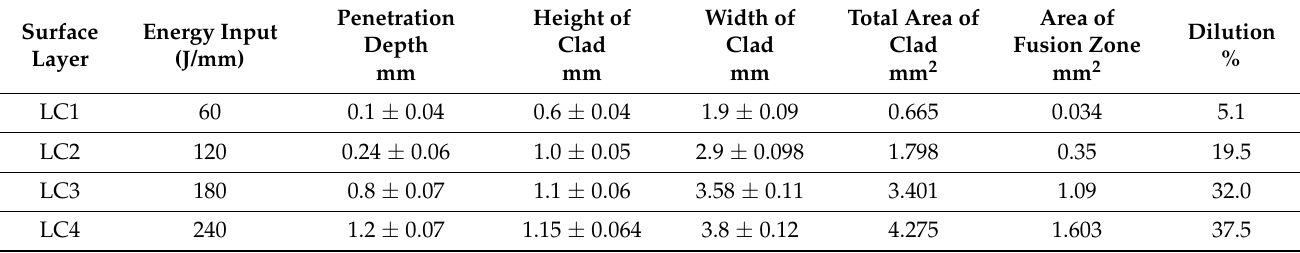
Table 3. Results of geometry determining for the stringer beads produced by laser cladding of experimental composite NiCrBSi/WC + W 2 C powder, Figure